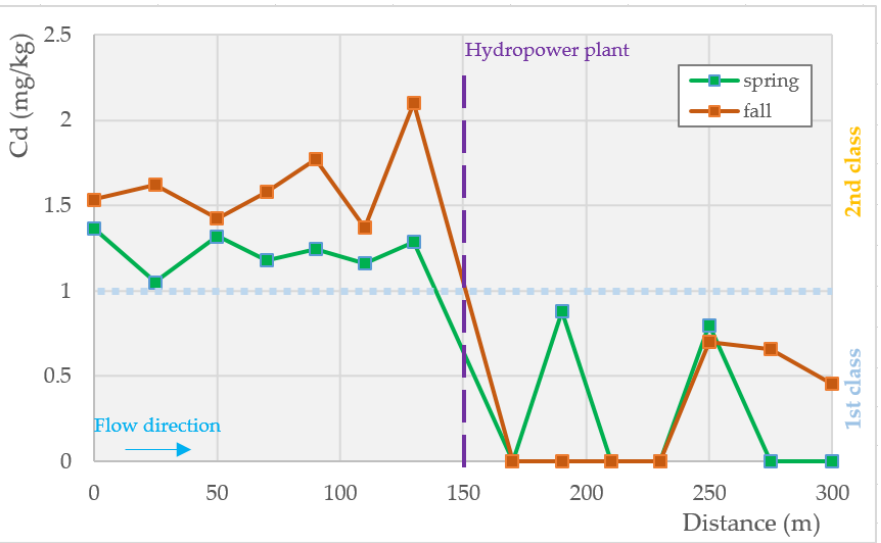
Figure 10. Changes in cadmium concentrations in sediments in spring and fall near the hydropower plant on the Ślęza River, along with the geochemical classification.